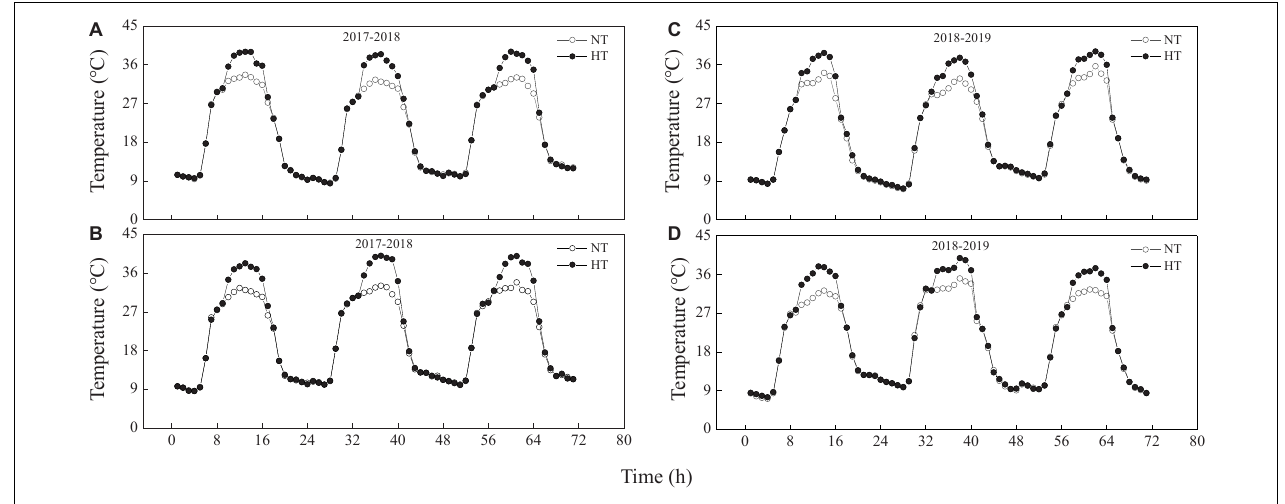
FIGURE 1 | The average temperature of the air at the flag leaf layer between delayed sowing and normal sowing during heat stress (19–21 DAA). (A,B) Are delayed sowing and normal sowing in the 2017–2018 growing seasons, respectively. (C,D) Are delayed sowing and normal sowing in the 2018–2019 growing seasons, respectively. NT, Natural temperature; HT, Temperature under heat